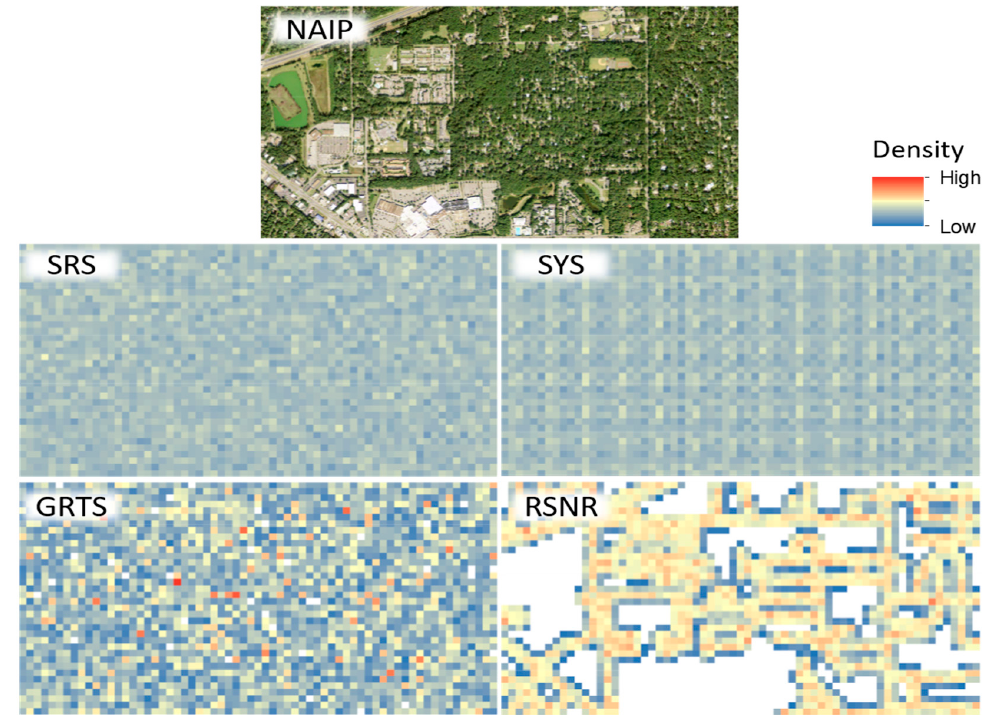
Figure 4. Illustration of spatial density of sample unit locations for each sample design across the study area. The NAIP image is used for reference; the density raster surfaces depict the frequency of selected cell locations for samples using the SRS, SYS, GRTS, and RSNR designs. To enhance the display of density surfaces, each surface was created by drawing 2000 random samples (sample size 50) for each design and counting the number of sample units falling within each density raster cell (50 m grain size). White cells within the density raster surfaces identify cells where no sample units were selected. SRS = simple random sample; SYS = systematic random sample; GRTS generalized random tessellation stratified; RSNR = random sample near